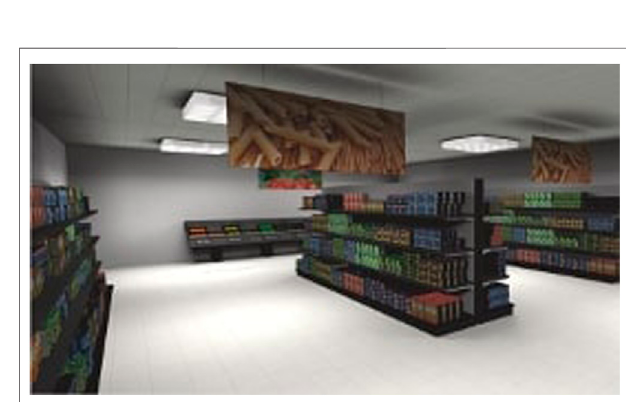
FIGURE 5 | Dickinson et al. (2020) included items such as paper slips, pens, and stools in the betting